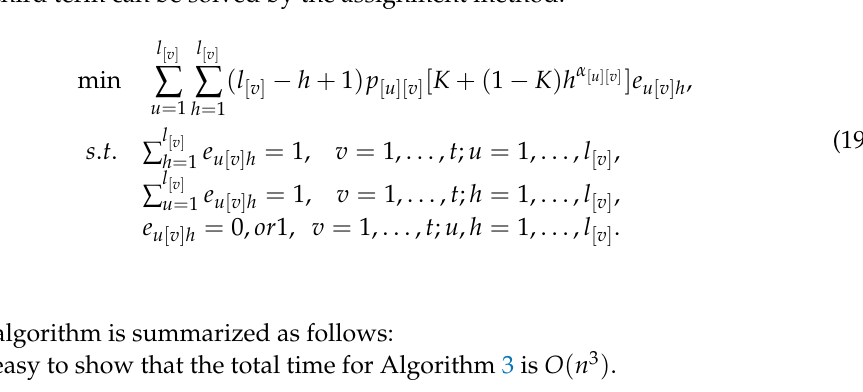
Algorithm 3 1 | p a